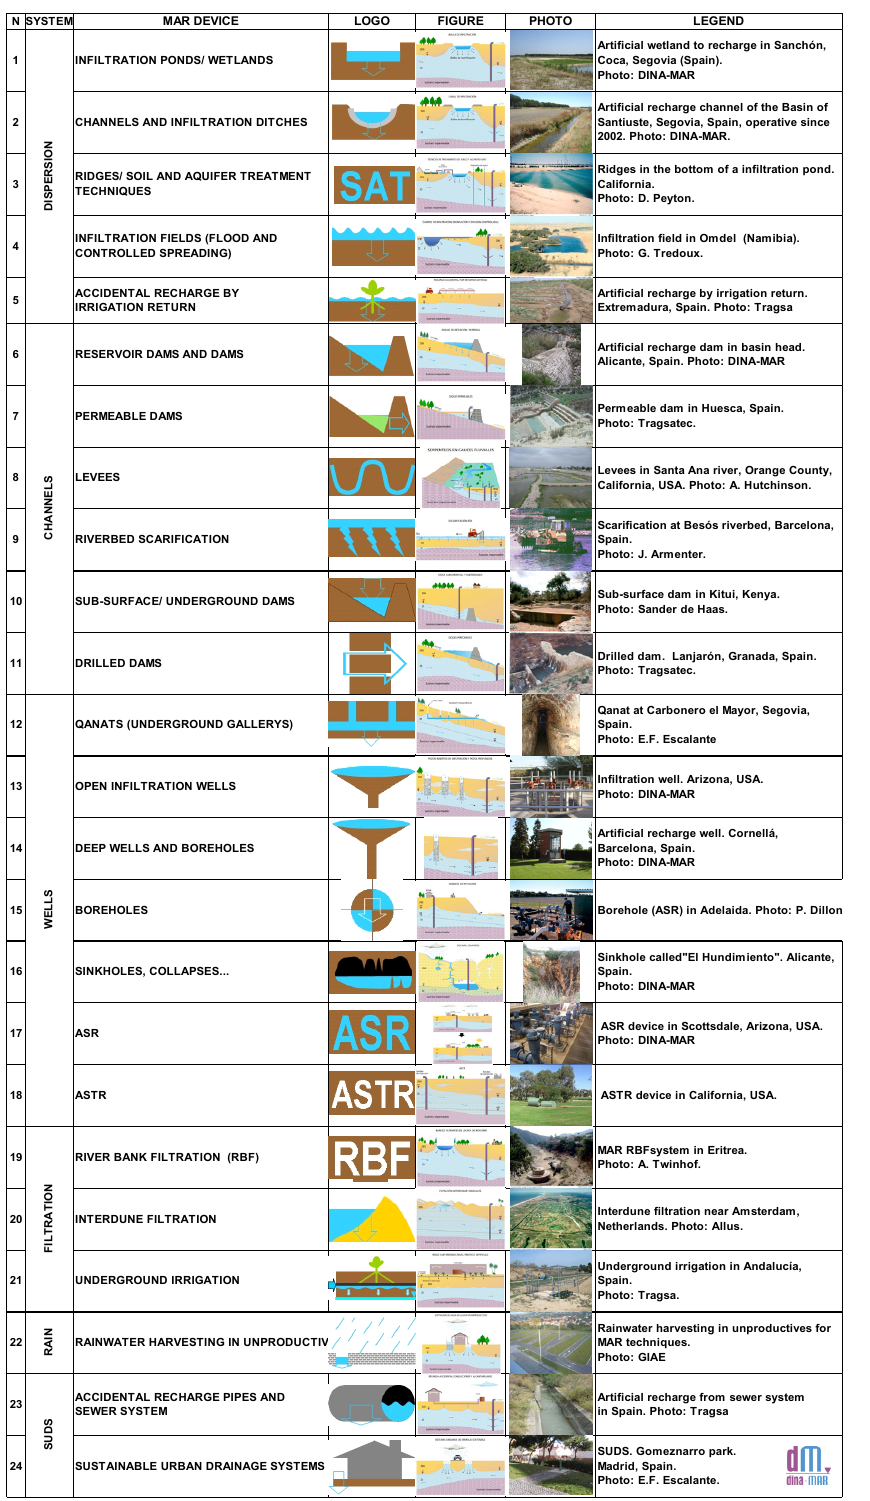
Figure 3. Inventory of feasible and applicable MAR devices, modified from Fernández & San Sebastián [9] (pp. 5–6).